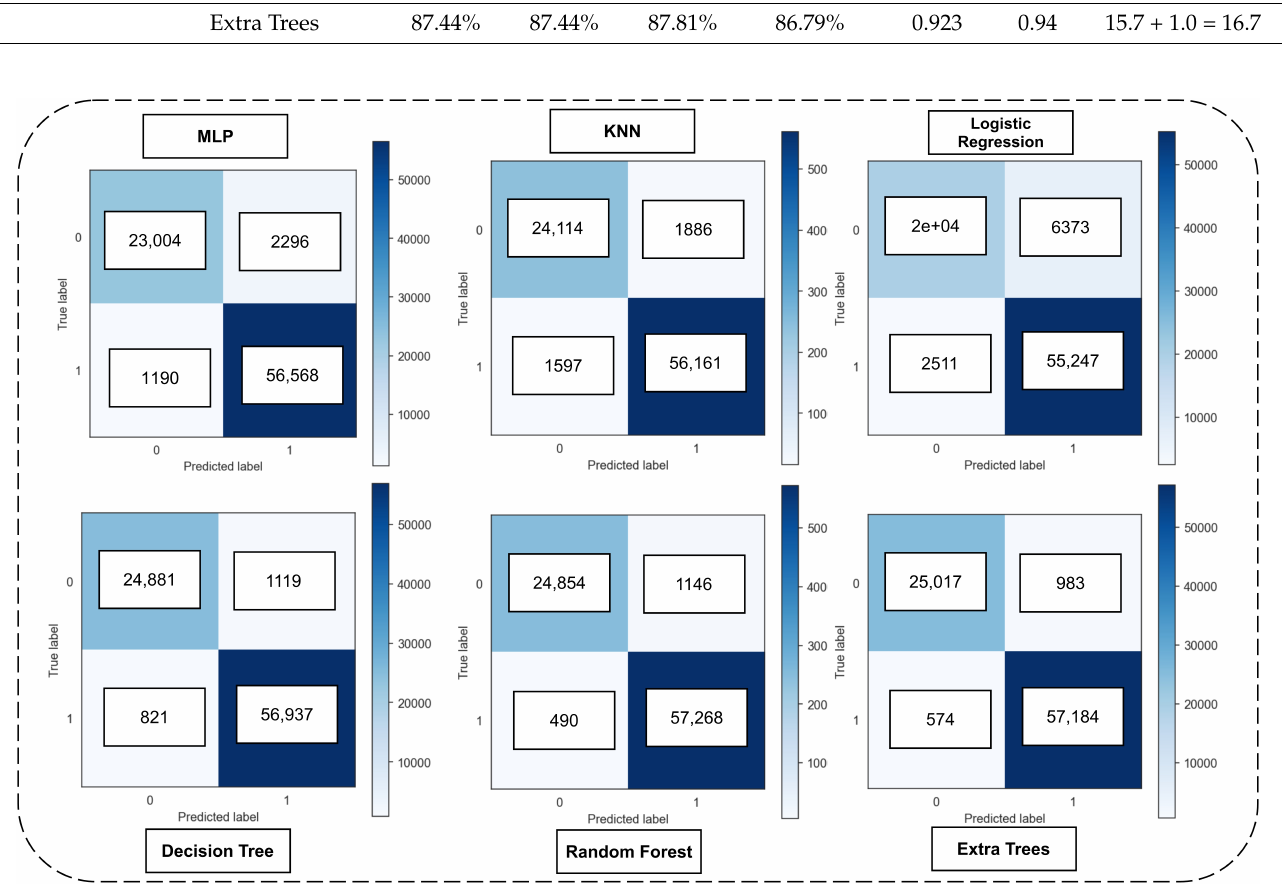
Figure 4. Confusion matrices of binary classification on original + GAN-based new